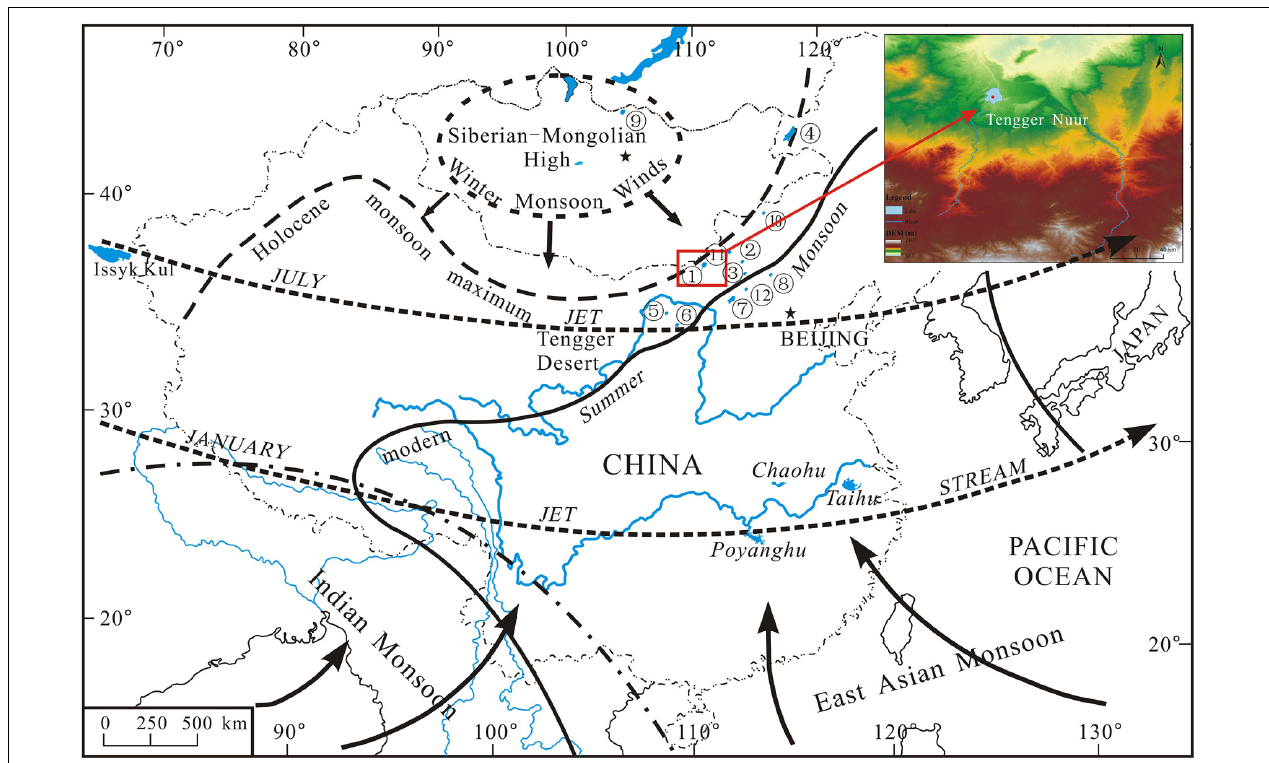
FIGURE 1 | Map of Asian monsoon region showing locations of paleoclimate records used in this study. (cid:192) Tengger Nuur, (cid:193) Daojiaohaizi, (cid:194) Dali Lake, (cid:195) Hulun Lake, (cid:196) Yanhaizi, (cid:197) Baahar Nuur, (cid:198) Daihai Lake, (cid:199) Bayanchagan Lake, (cid:200) Gun Nuur, (cid:201) Haolaihure, ⑪ Angulinao, ⑫ Huangqihai. Lines indicate modern extent of East Asian and Indian monsoons (dashed lines) and maximum area extent of monsoons during the Holocene (solid line), as mapped by Winkler and Wang (1993).